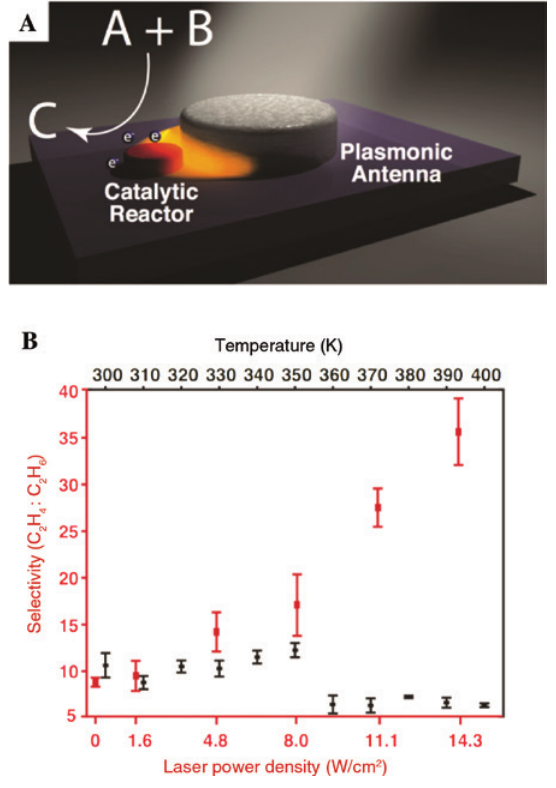
Figure 13: Plasmon-mediated photocatalytic reactions using a heterometallic antenna-reactor